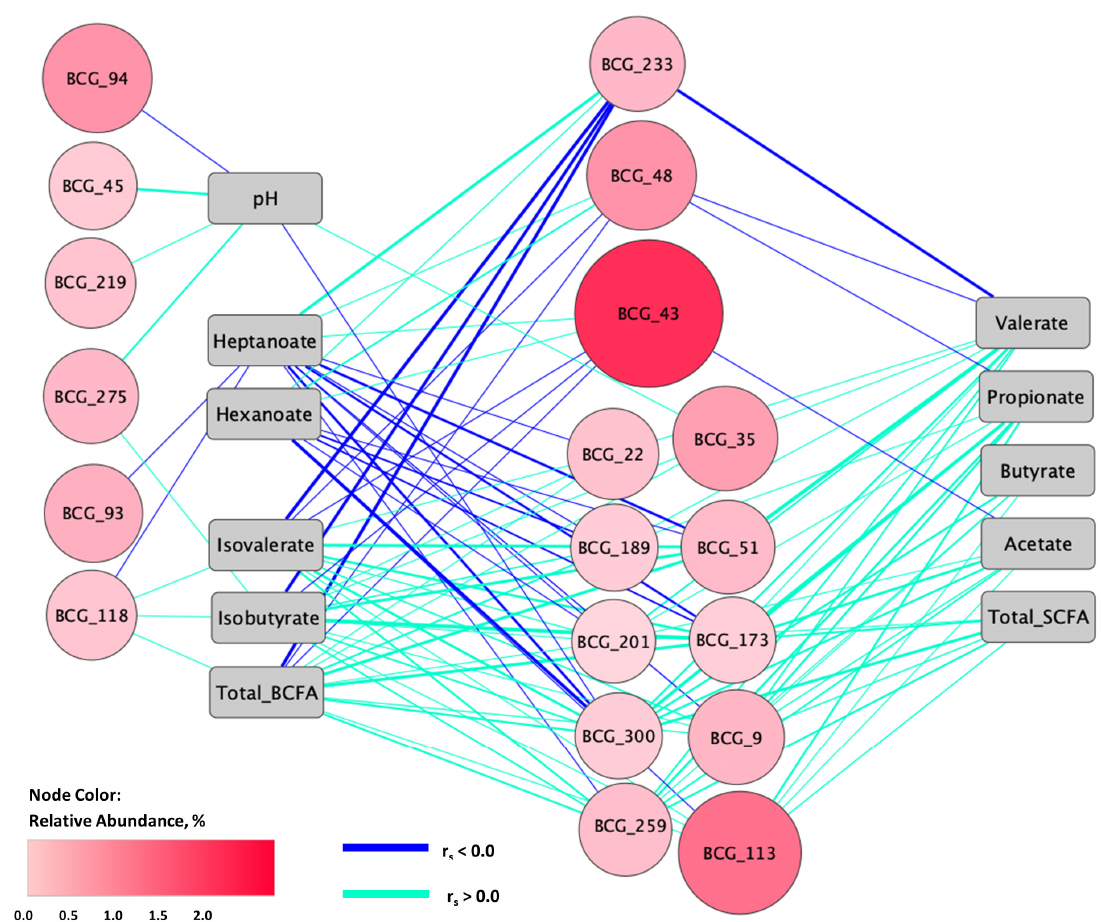
Figure 5. Network map of bacterial co-abundance groups (BCG) and fermentation metabolites as well as fecal pH. Correlations were evaluated between BCA most predictive of forage type (based on random forest modeling of BCG composition) and fecal pH, short-chain fatty acids (SCFA) and branched-chain fatty acids (BCFA). In addition to node color, node size was also mapped to BCG relative abundance. Line width is mapped to correlation strength, with wider lines indicating stronger correlations between nutrients and BCG. Significant Spearman correlations (r s ≥ |0.30|; p ≤ 0.05) were included in the network map.